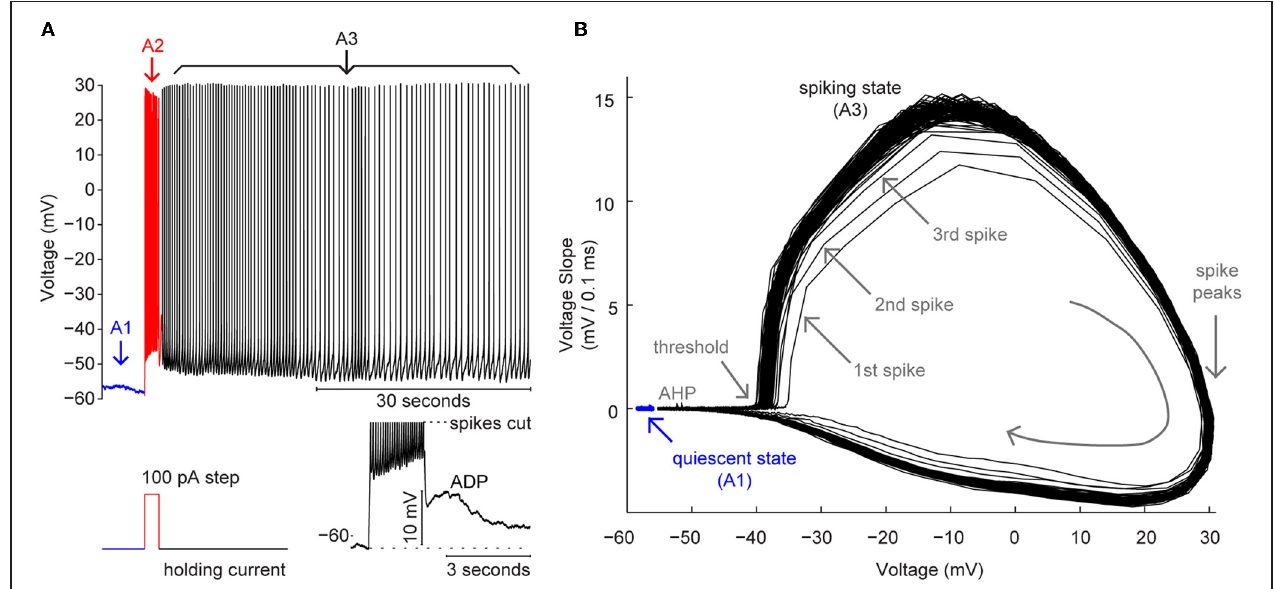
FIGURE 3 | Bistable persistent spiking. (A) (Top) Recording from a layer V mEC neuron during the typical protocol used to elicit persistent spiking. Note, the recorded neuron was quiescent (A1) prior to delivery of a 100pA current step (A2) (stimulus depicted in Bottom left panel ). After the current step, the recorded neuron spiked continuously (A3, ∼ 1minute shown). (A) (Bottom right panel) Recording from another layer V mEC neuron illustrating a stimulus evoked, after-depolarization. This voltage profile reflects the inward CAN current carried by TRPC channels and often results when the applied holding current (as depicted to the left) is insufficient to support